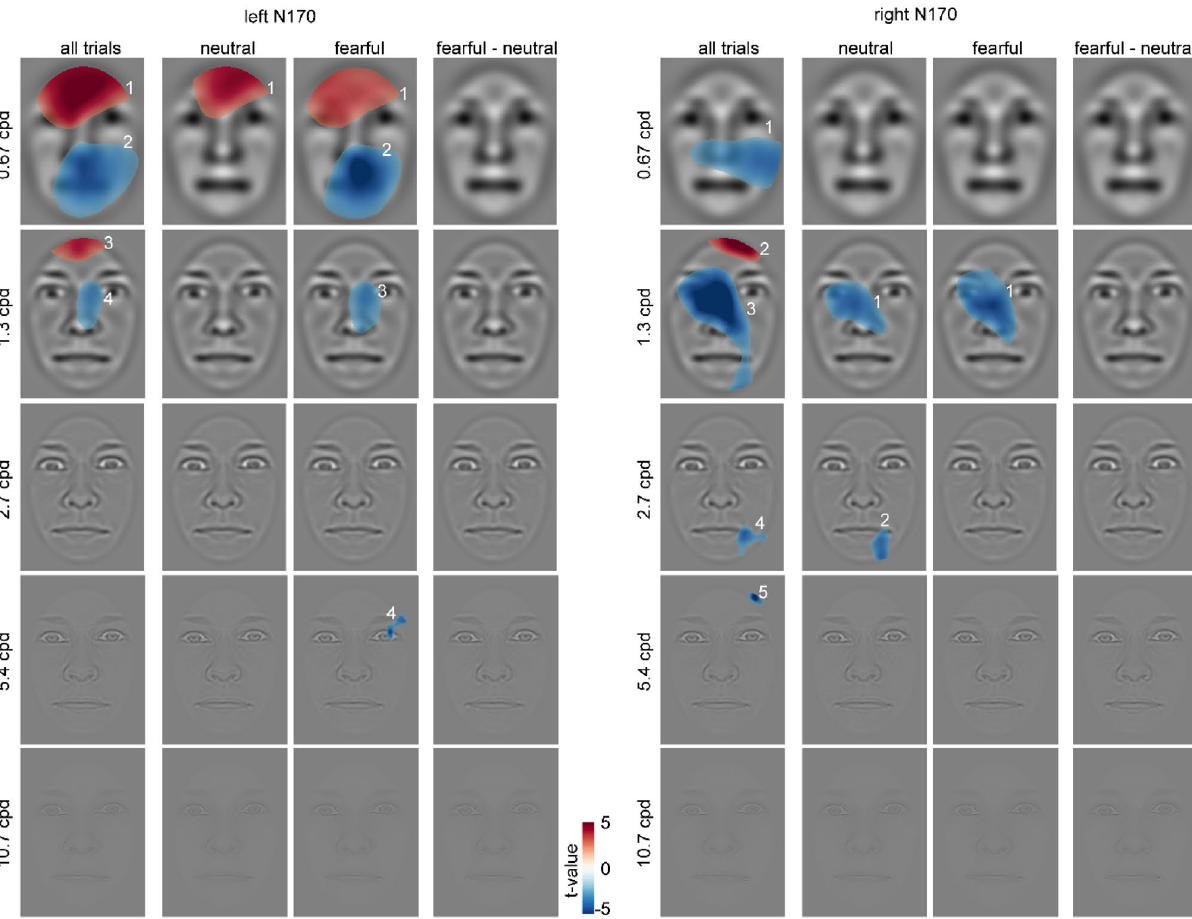
Figure 6. Classification images for the N170 component depicting face regions that contributed significantly to an amplitude increase (red) or decrease (blue). The clusters are enumerated to assign them to the respective statistics reported in the main text. Please note that the electrodes used for classification image calculations were chosen individually (see “Methods” section), whereas the ERP data in Fig. 5 are based on common sensors for